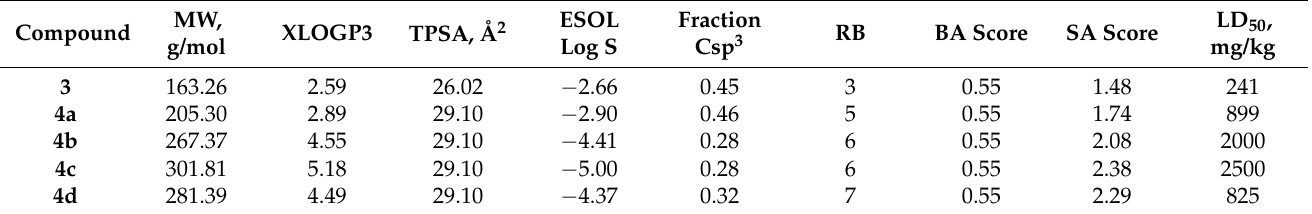
Table 2. Calculated ADME parameters of the compounds 3 and 4a – d representing